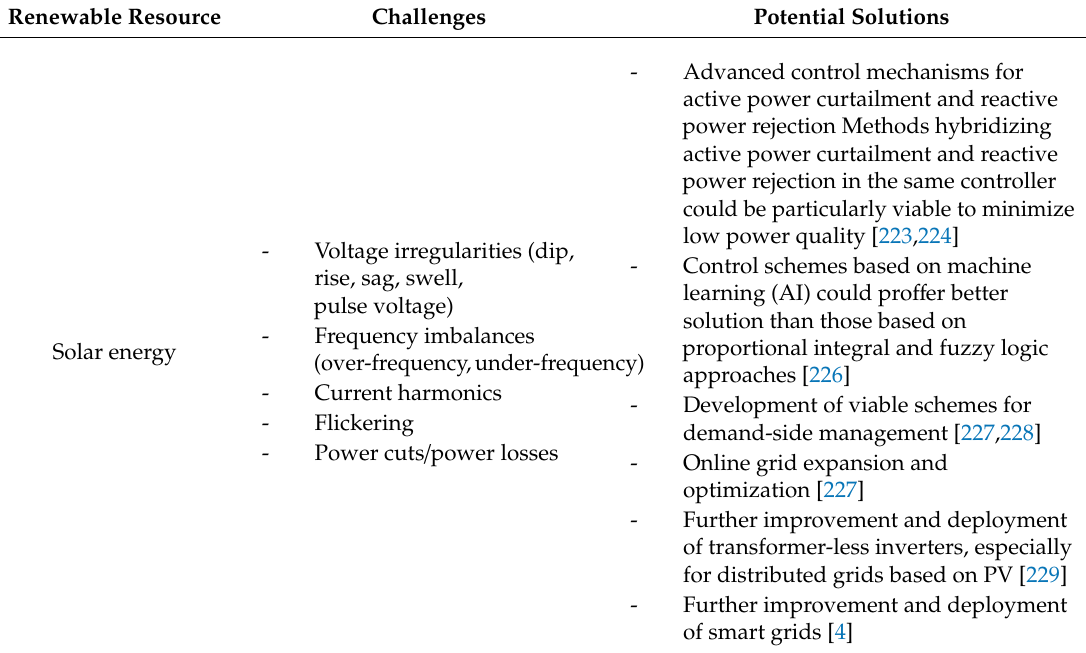
Table 3. Common challenges of renewable energy sources at the electrical grid